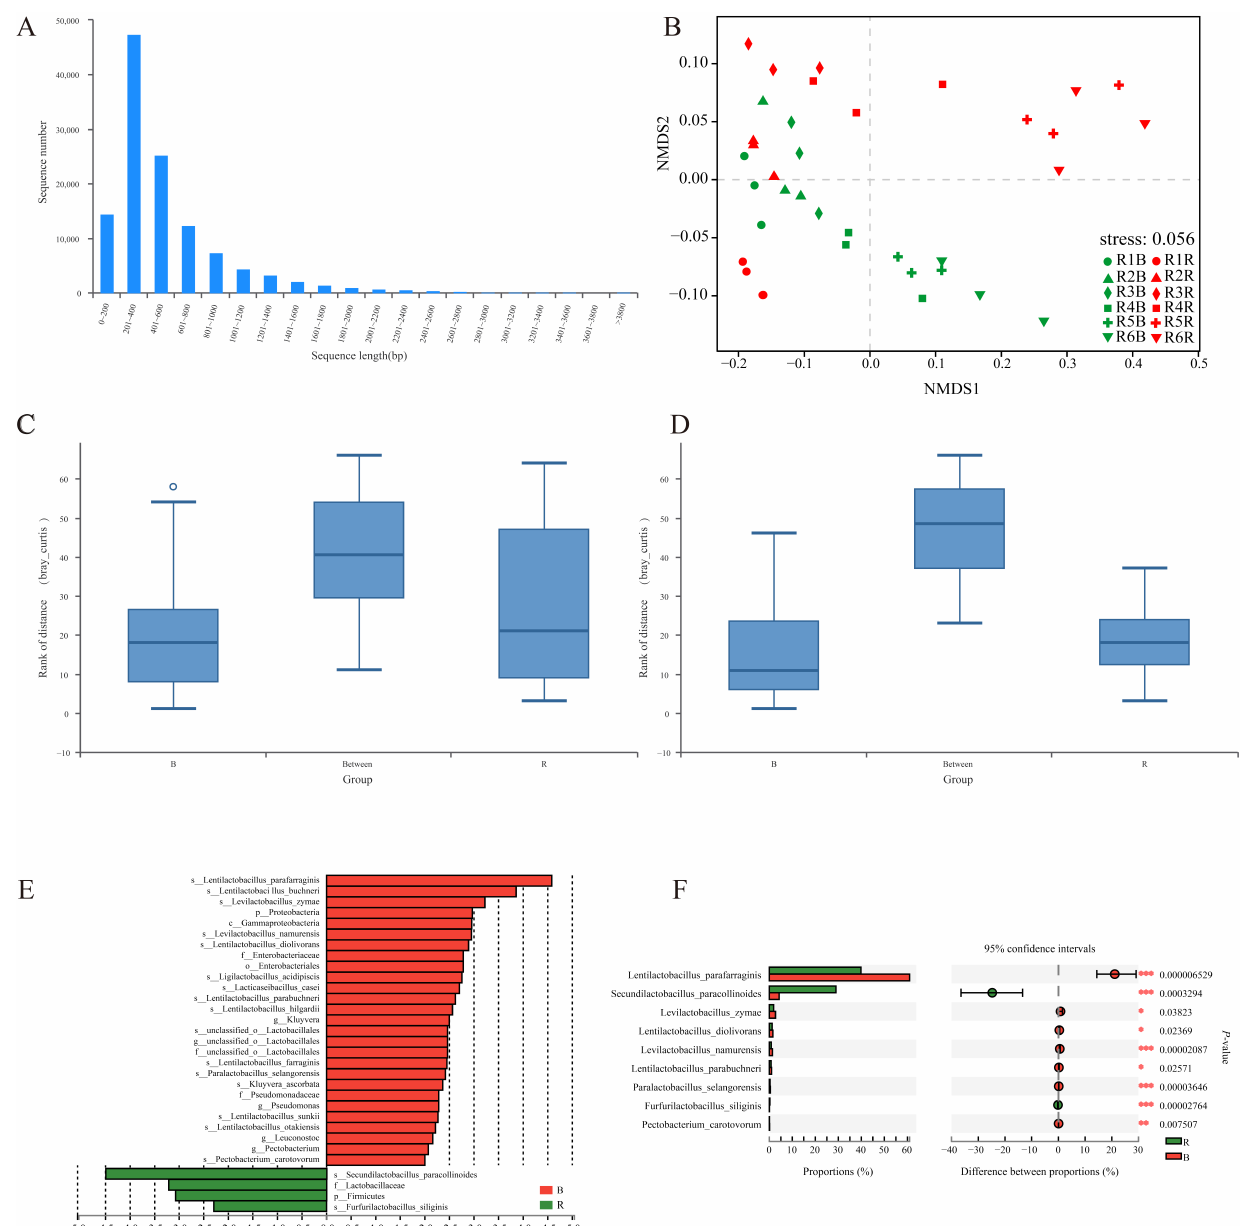
Figure 1. ( A ) Sequence length distribution of nonredundant gene catalog. ( B ) NMDS analysis at species level. Analysis of similarities between different groups by ANOSIM ( C , D ) of red radish paocai and cabbage paocai in the 3rd and 4th round, separately. ( E ) LDA score of the two kinds of red radish paocai and cabbage paocai. ( F ) Wilcoxon rank-sum test of different species in red radish paocai and cabbage paocai. * 0.01 < p ≤ 0.05, ** 0.001 < p ≤ 0.01, *** p ≤